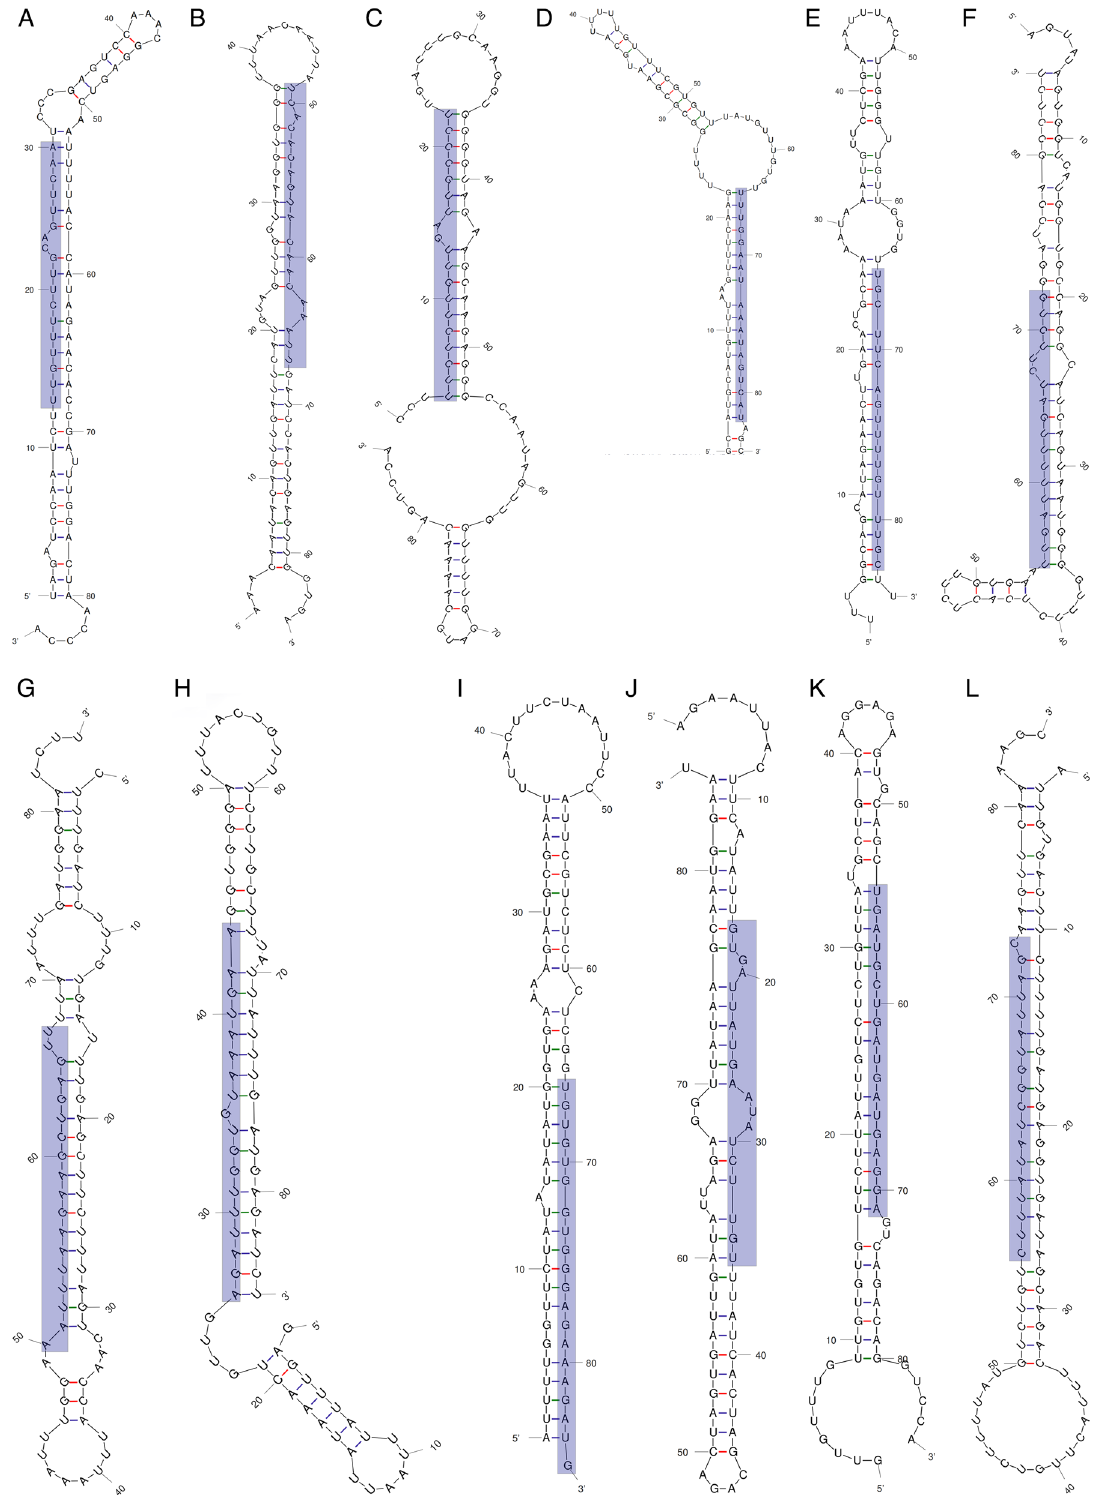
Fig. 2 Newly identified mature miRNAs (highlighted) in the stem loop structures of pre-miRNAs. A jcu-miR5277, B jcu-miR9741, C jcu-miR7121, D jcu-miR1534, E jcu-miR6149-3p, F jcu-miR11155c-3p, G jcu-miR4249, H jcu-miR7805-3p, I jcu-miR8786, J jcu-miR3520-5p, K jcu-miR5658, L